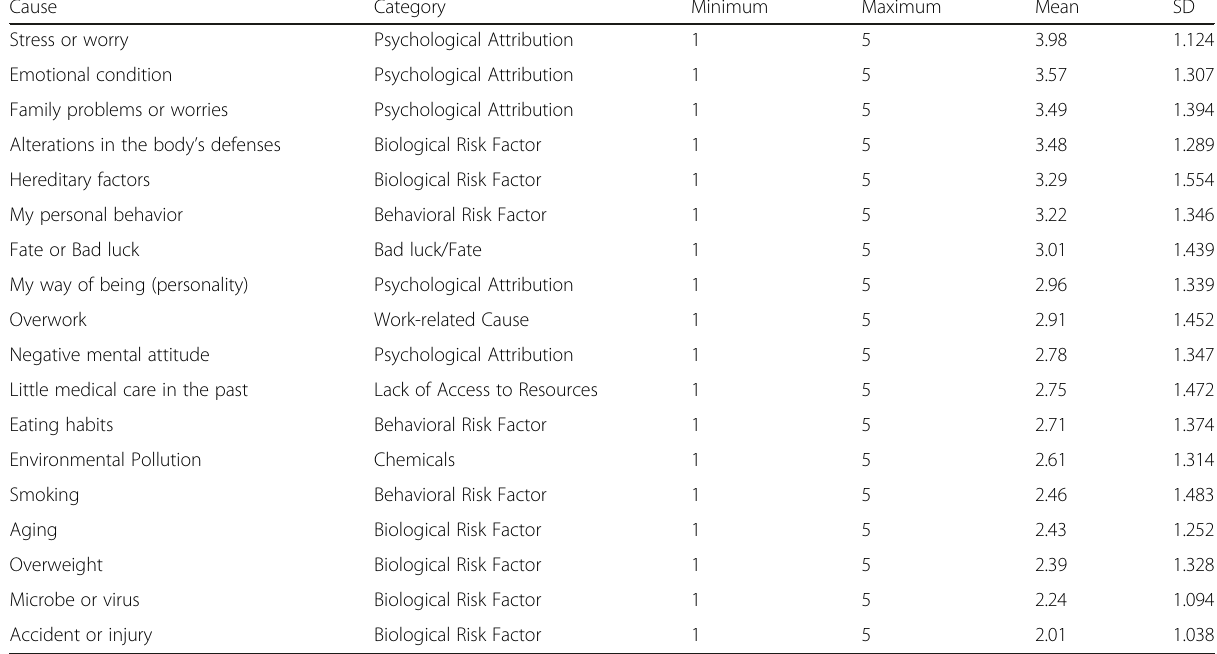
Table 2 Minimum, maximum, mean and standard deviation of the items of the causal dimension of the RIPQ ( N =